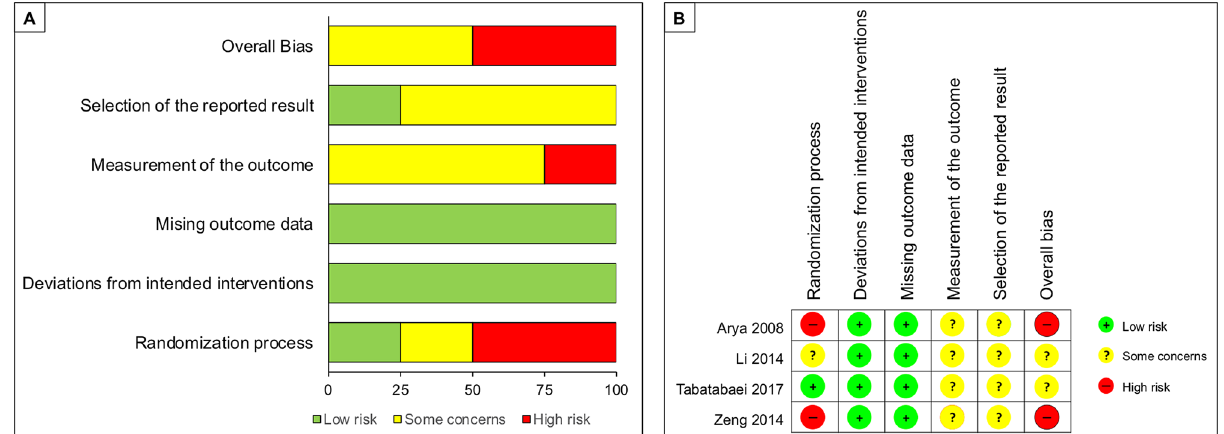
Figure 2. Risk of bias assessment of all included randomized controlled trials (RCTs) based on revised risk of bias tool (RoB 2). ( A ) A summary of review authors’ judgements about each risk of bias item presented as percentages across all included RCTs. ( B ) Review authors’ judgements about each risk of bias item presented individually for all included RCTs.